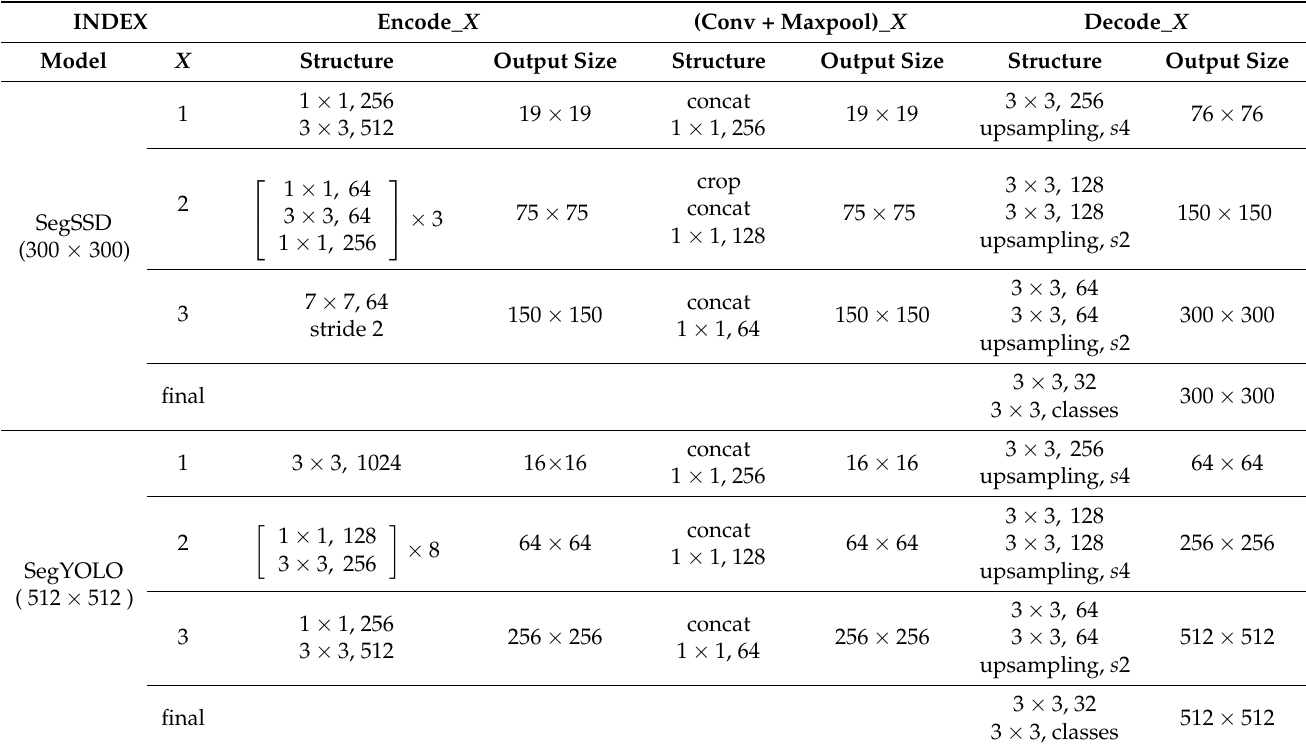
Figure 2. The collocation structure of Segmentation Block and basic target detection algorithm. Upward arrows in segmentation block indicate upsampling. Bolded arrows indicate the delivery of one or more feature maps. The green rectangle is the output result of the basic algorithm and the blue rectangle is the bounding box with the segmentation block, w and h are the input size of basic detection algorithm. Table 1. SegSSD and SegYOLO detail parameters. X means the layer name. ‘ s ’ in decode indicate scale factor.